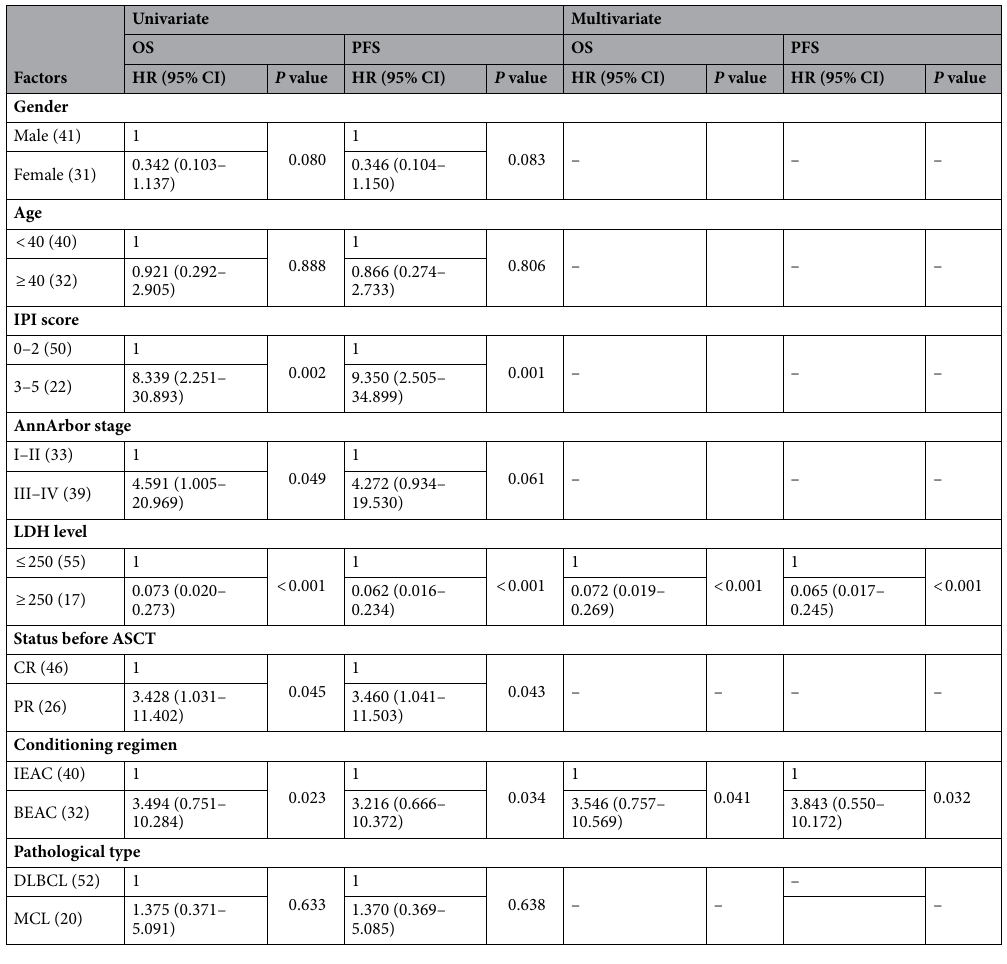
Table 4. Univariate and multivariate analysis of factors potentially associated with survivals. IPI international prognostic index, LDH lactate dehydrogenase, CR complete remission, PR partial remission, ASCT autologous stem cell